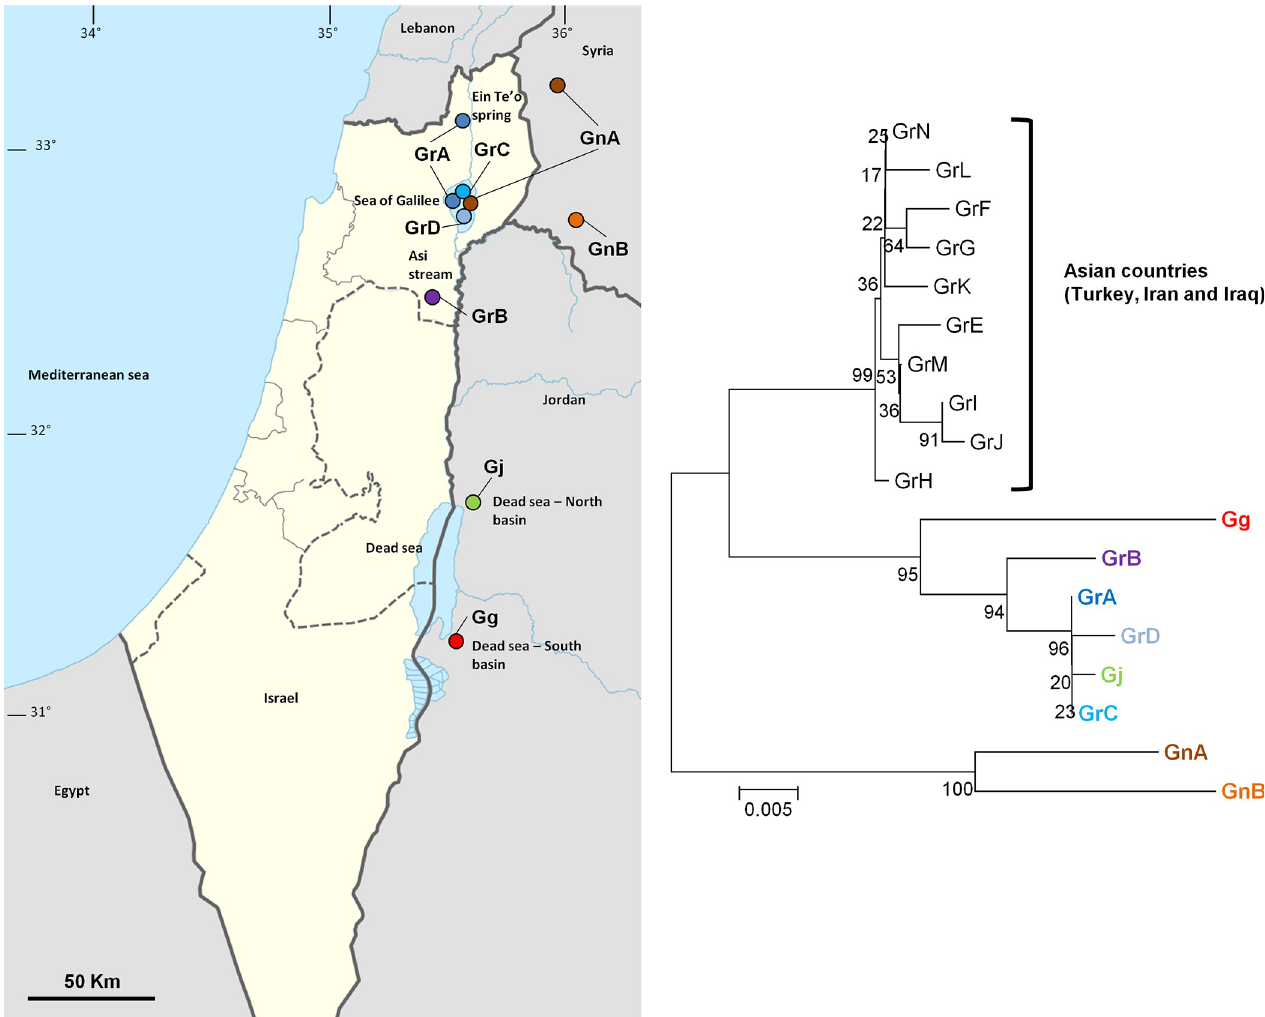
Fig 2. Sampling sites and clustering of Garra samples based on COI haplotypes. Acronyms of populations are: GrA– Garra rufa from haplotype A; GrB– Garra rufa from haplotype B; GrC– Garra rufa from haplotype C; GrD– Garra rufa from haplotype D; Gg– Garra ghorensis from the southern basin of the Dead sea; Gj– Garra Jordanica from the northern basin of the Dead sea; GnA– Garra nana from haplotype A; GnB– Garra nana from haplotype B. (A) Map showing the sampling sites in a regional context. Different Garra haplotypes were denoted by differently colored circles in each sampling site on the regional map. Map was reprinted from DMY + NordNordWest (https://commons.wikimedia.org/wiki/File:Israel_by_israeli_law_adm_location_map.svg), under a CC BY-SA 4.0 license, original copyright 2017. (B) A neighbor-joining unrooted tree constructed for haplotypes obtained from samples collected in this study alongside haplotypes mined from BOLD. Next to the edges are haplotype acronyms as indicated above and next to bifurcations are percent bootstrap support values. Haplotype text colors in the tree match circle colors in the map